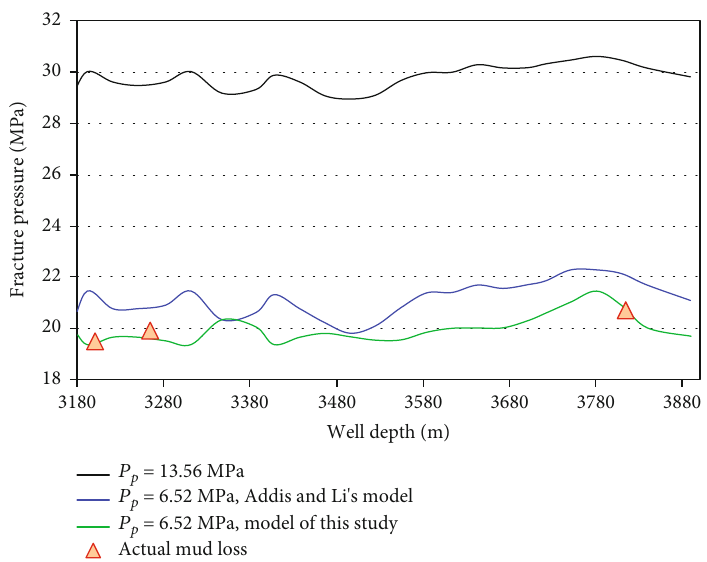
Figure 5: Comparison between the fracture pressure in di ff erent models and actual mud loss